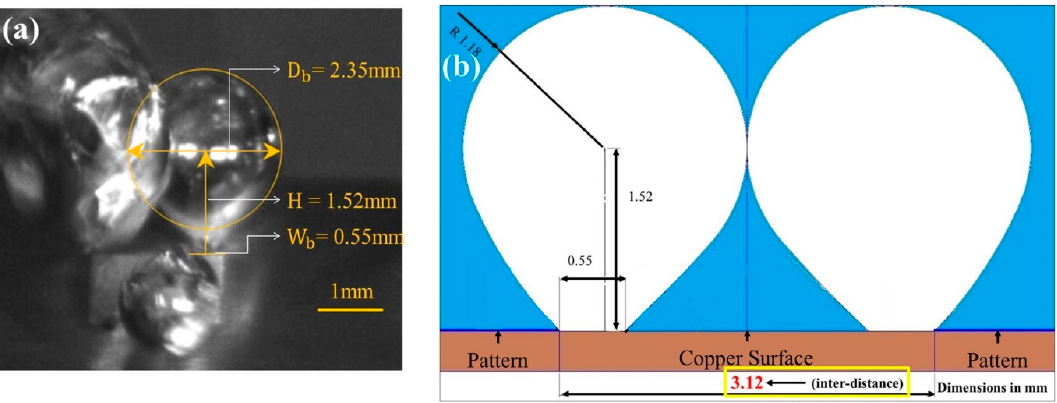
Figure 14. ( a ) Measured bubble departure size at the interface of the pattern and copper and ( b ) the minimum graphically estimated patterns. minimum graphically estimated